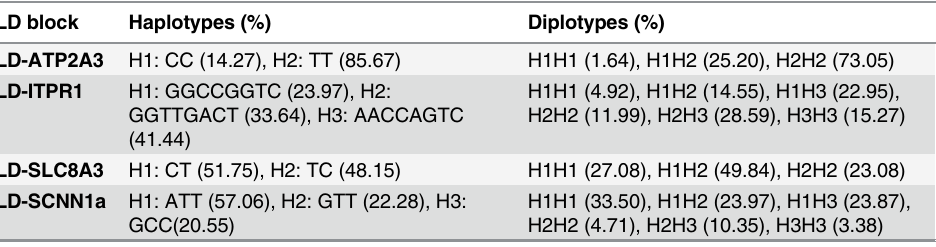
Table 3. Major haplotypes (frequency > 1%) and diplotypes (frequency > 1%) in 4 linkage disequilib- rium (LD) blocks.